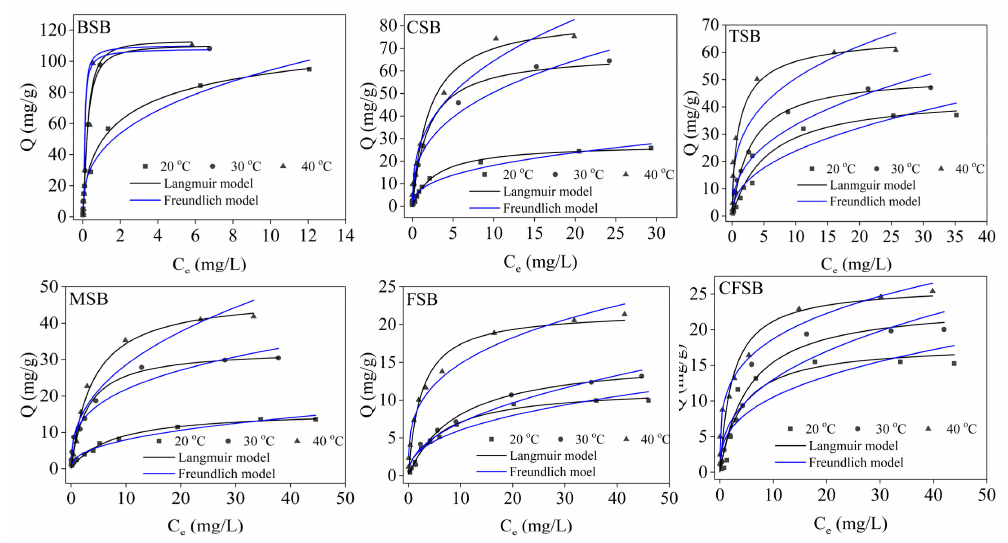
Figure 7. Adsorption isotherms of Cr(VI) for six di ff erent